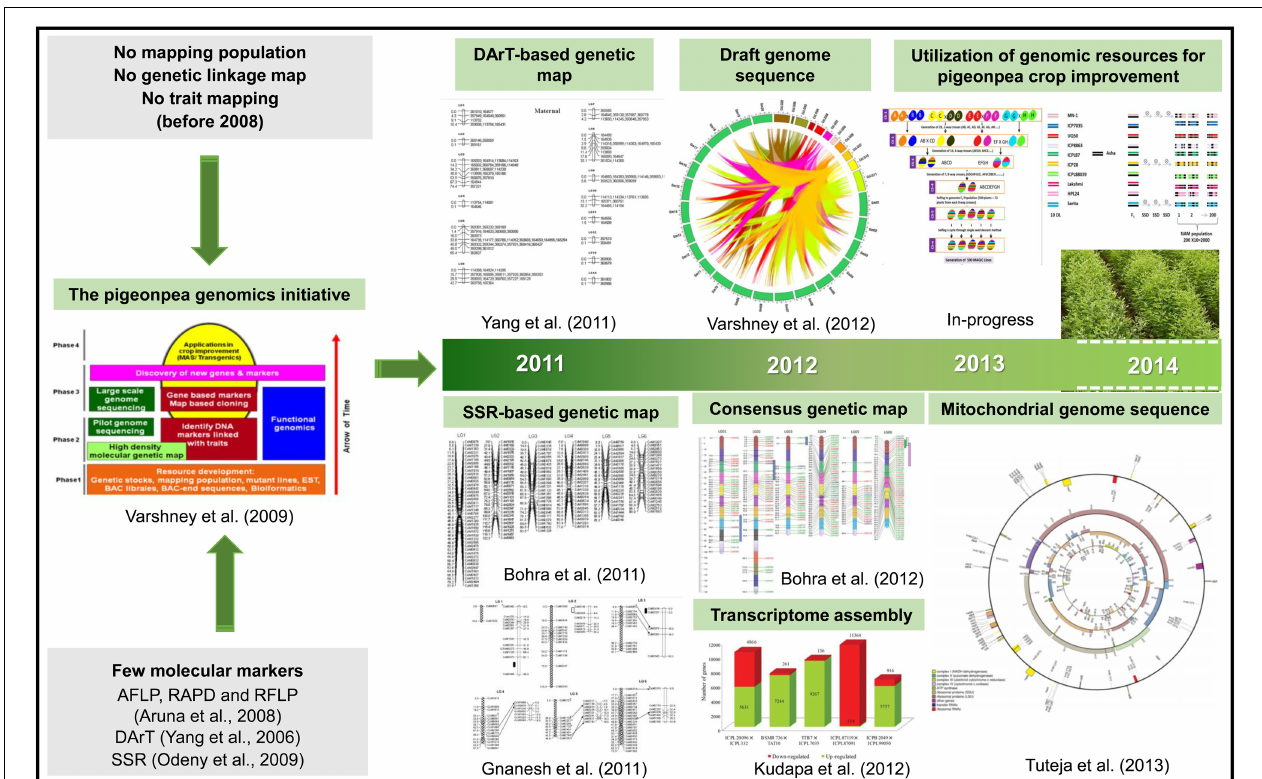
FIGURE 1 | A glimpse of the pigeonpea genomics research. The figure depicts the present scenario in terms of major genomic resources developed during the last decade that would lead to pigeonpea crop improvement. There were very few markers and with no mapping population developed before Pigeonpea Genomics Initiative (PGI). Since the inception of PGI in 2006, progress were made in developing various